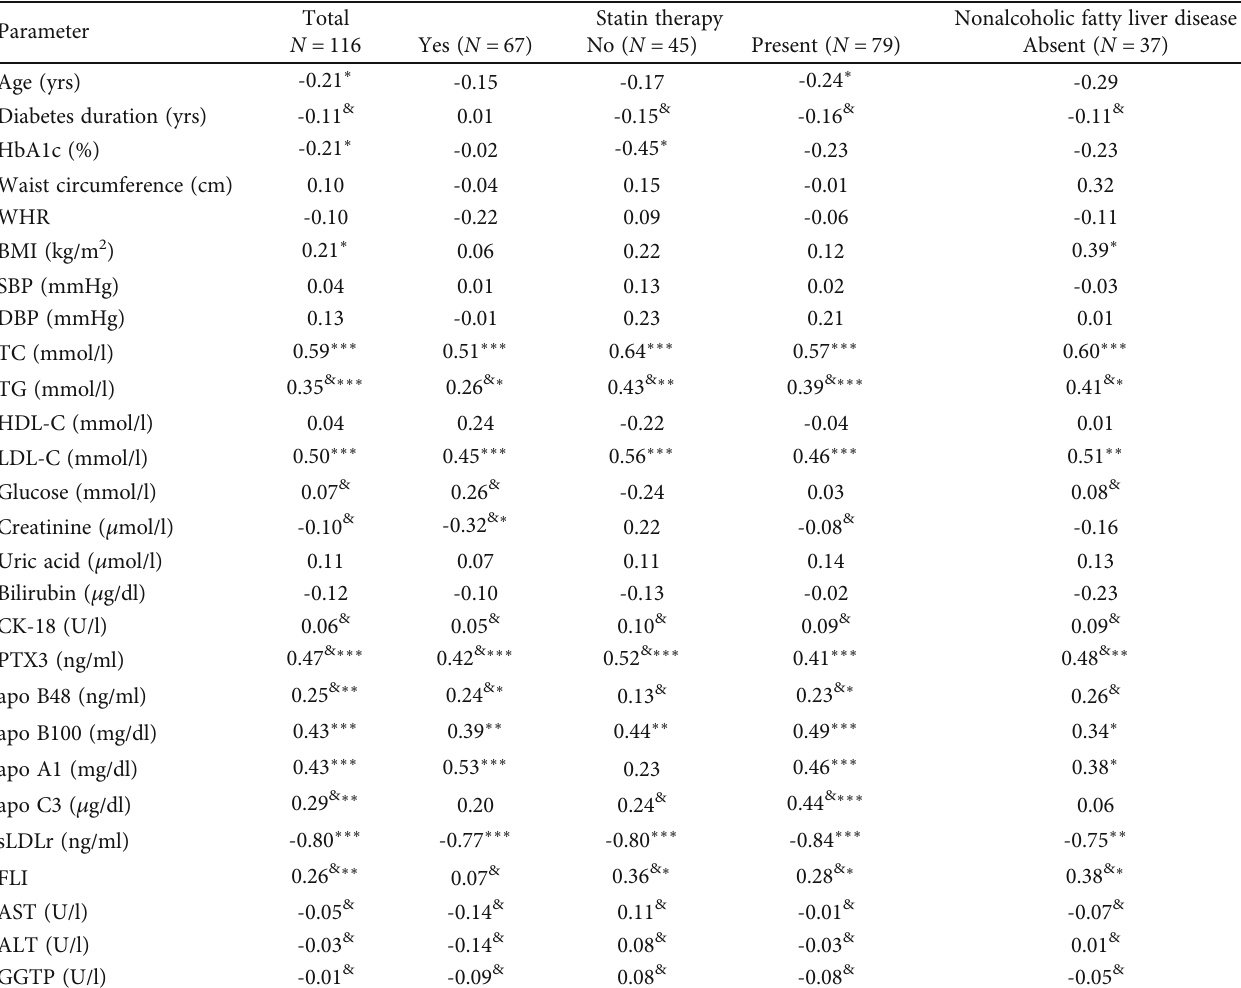
Table 3: Pearson ’ s and Spearman ’ s & correlation coe ffi cients between PCSK9 and chosen variables in patients with type 2 diabetes in the studied group and according to statin treatment and presence of